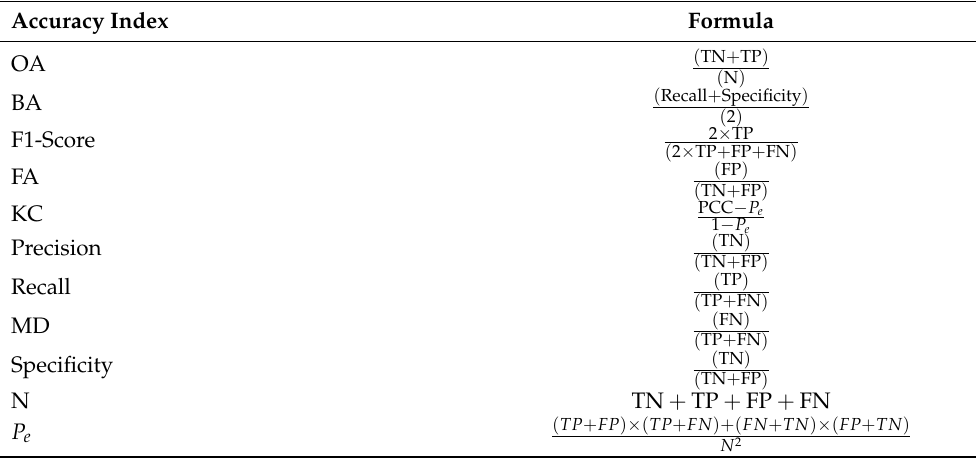
Table 2. The metrics were used for the accuracy assessment of the built-up